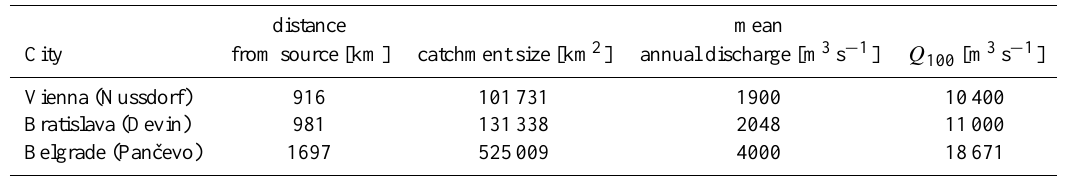
Table 1. Danube case studies – general information.